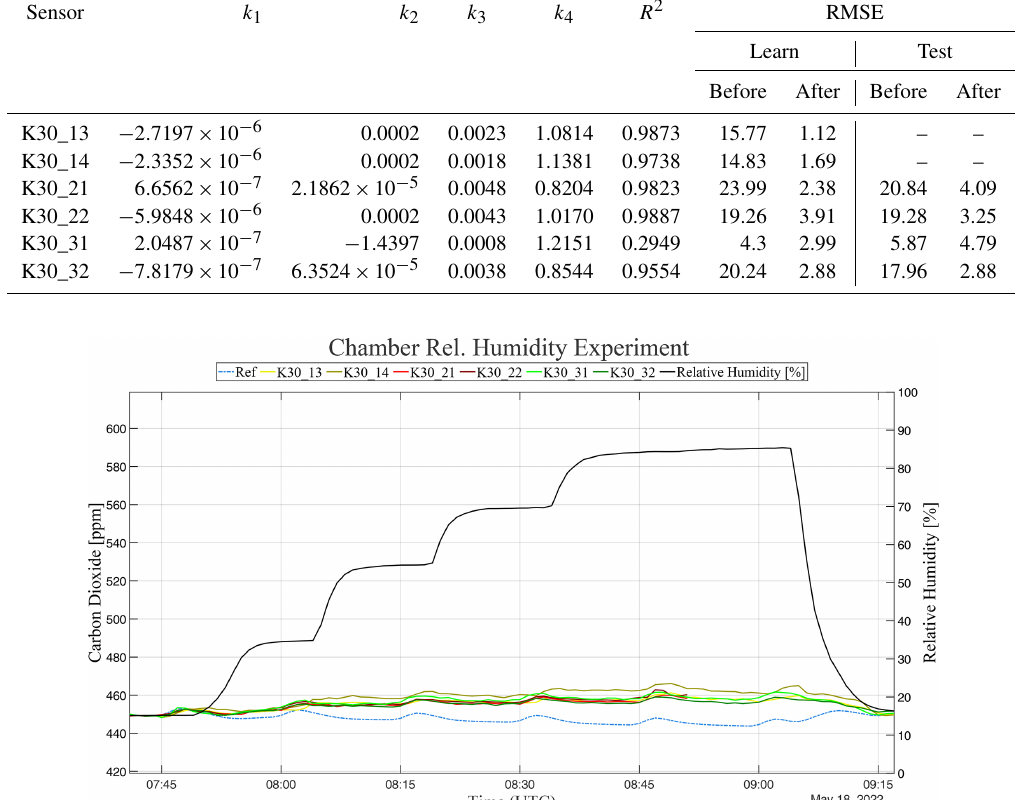
Table 2. Coefficients for the temperature correction method. The RMSE values are relative to the reference sensor inside the test volume.